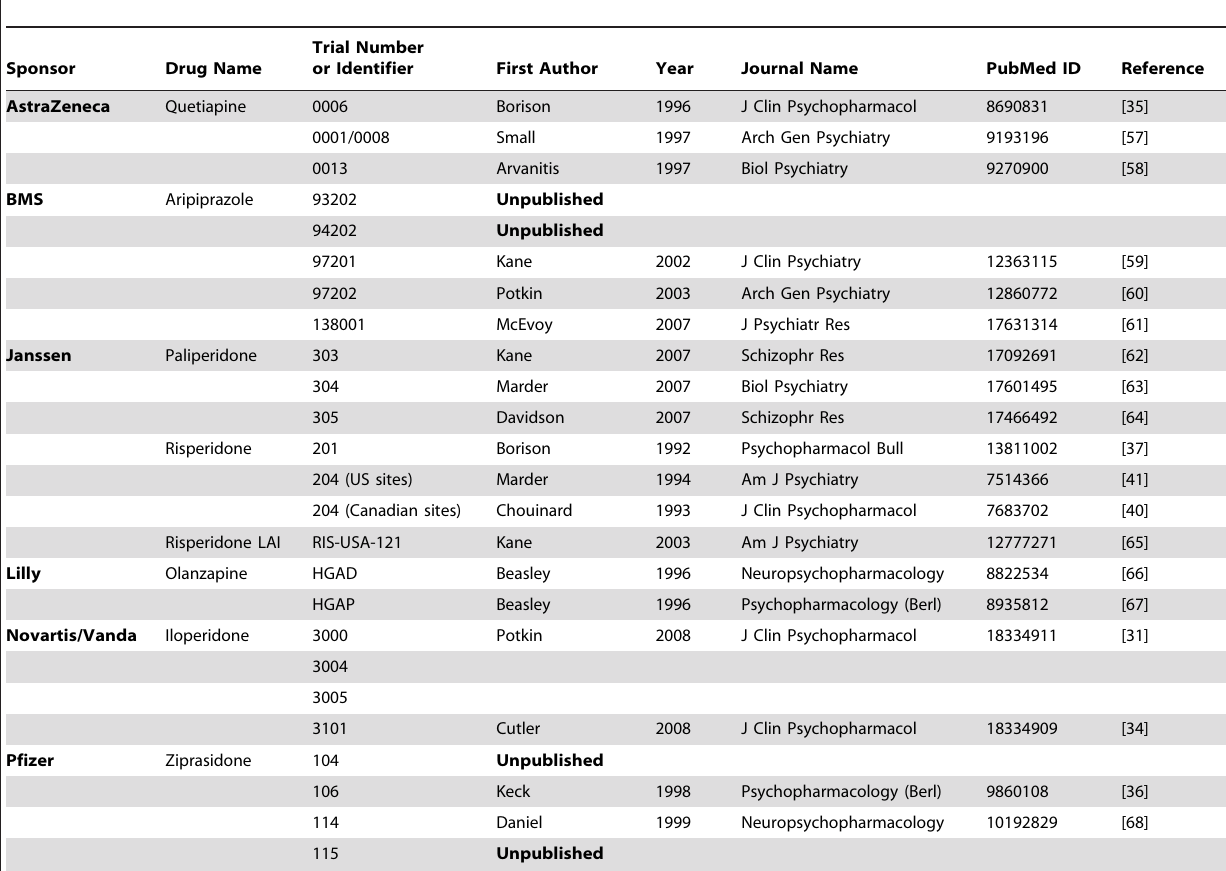
Table 2. Bibliographic information on FDA-registered antipsychotic